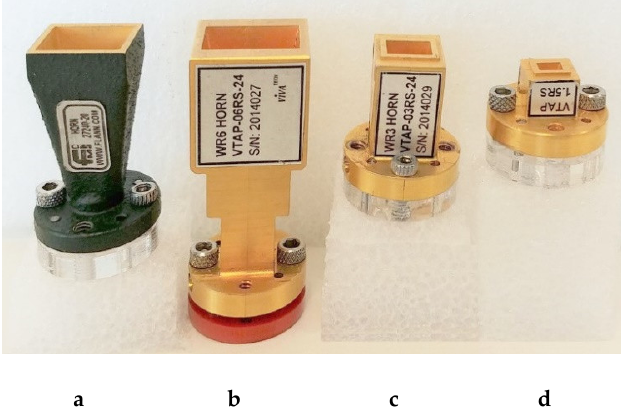
Figure 6. Antennas: ( a ) 79 GHz, ( b ) 150 GHz, ( c ) 300 GHz, and ( d ) 670 GHz. For 79 GHz measurement we chose 4 GHz bandwidth which is defined by the European frequency regulation [42] for automotive radars in the 79 GHz frequency band. At higher frequencies, the wider bandwidths can be readily achieved to improve range resolution. Therefore, to resolve extended targets/surfaces with the imaging radar the 16 GHz bandwidth has been used for 150 GHz, 300 GHz, and 670 GHz radar measurement and the bandwidth kept the same to compare the results. The sandpaper rms height was measured in [43], and they are shown in Table 3 together with measured total thickness with backing paper/fabric and calculated electromagnetic roughness. The parameters given in [43] should be considered approximate, since there are no strict standards for sandpaper and the roughness can vary from batch to batch within certain limits. Table 3. Sandpaper Parameters. Grit Thickness, mm